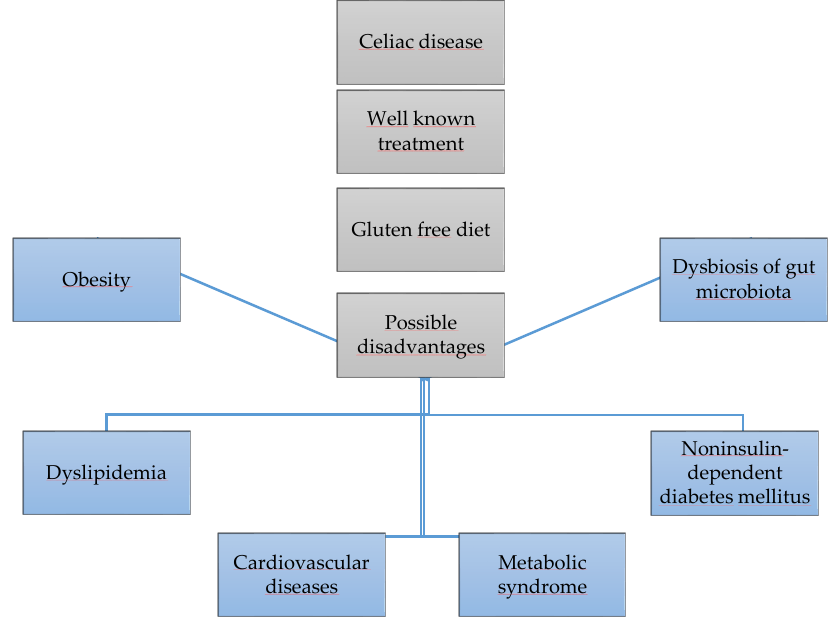
Figure 1. Gluten free diet and its risks.